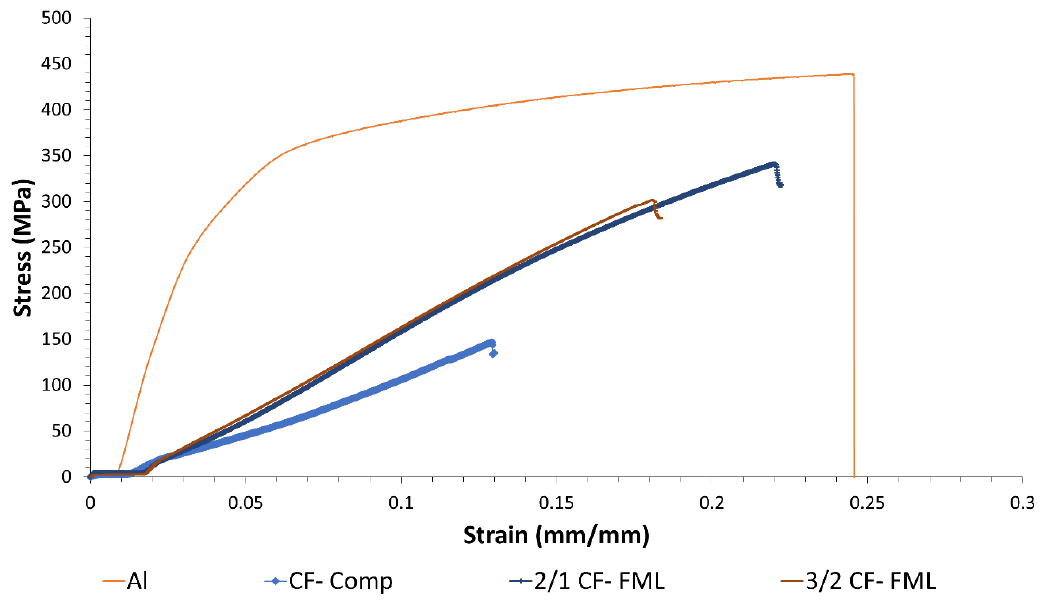
Figure 5. Representative tensile stress-strain curve of plain Al and carbon fiber (CF) FMLs.